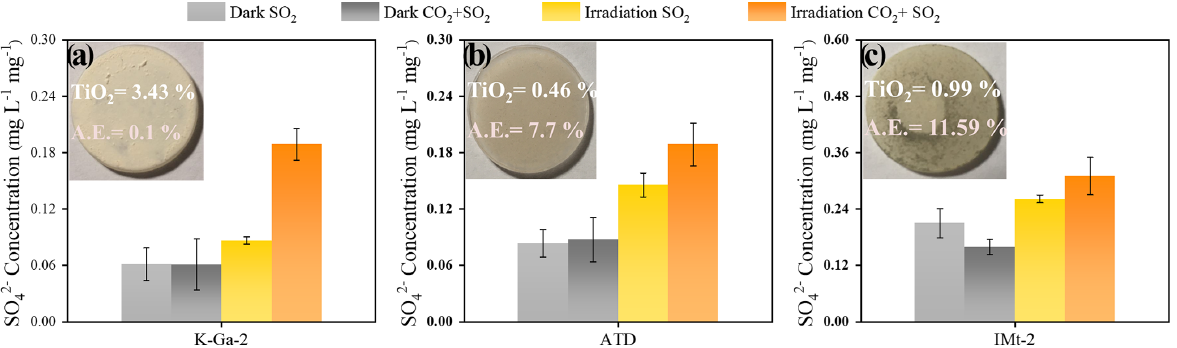
Figure 6. Laboratory studies of sulfate production on authentic dust and clay membranes (a) K-Ga-2, (b) ATD, and (c) IMt-2 un- der the dark and irradiation (30mWcm − 2 ) upon exposure to 4.91 × 10 14 molec.cm − 3 SO 2 / N 2 + O 2 and 2.46 × 10 18 molec.cm − 3 CO 2 + 4.91 × 10 14 molec.cm − 3 and SO 2 / N 2 + O 2 at RH of 30%. Note that the sulfate yield in three cases was normalized by the mass of dust particles employed for a heterogeneous